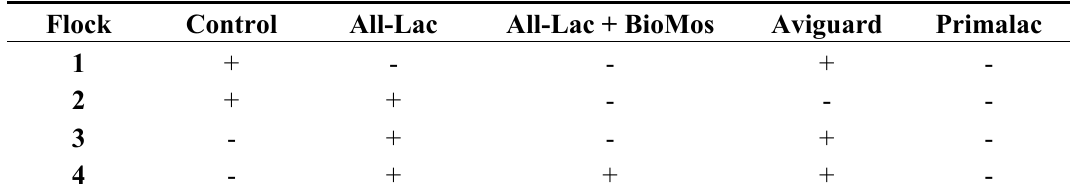
Table 8. Prevalence of Salmonella in litter of 4 sequential flocks of broiler chickens administered probiotics or prebiotics and reared in research housing. Flock Control All-Lac All-Lac + BioMos Aviguard Primalac